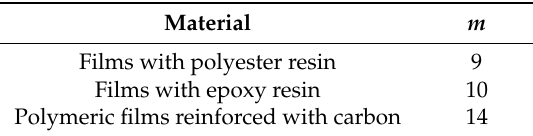
Table 1. Values of the parameter m [31].